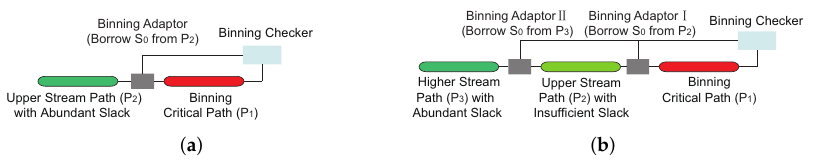
Figure 5. The insertion of Binning Adaptor under two different scenarios. ( a ) The upper stream path of the Binning Critical Path has a slack larger than S 0 . Then only one Binning Adaptor is needed; ( b ) The upper stream path of the Binning Critical Path has a slack smaller than S 0 . Hence multiple Binning Adaptors are